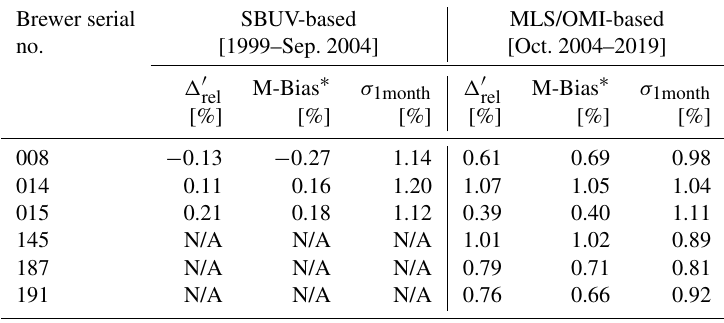
Table 7. World and European regional reference instruments’ 3-month standard